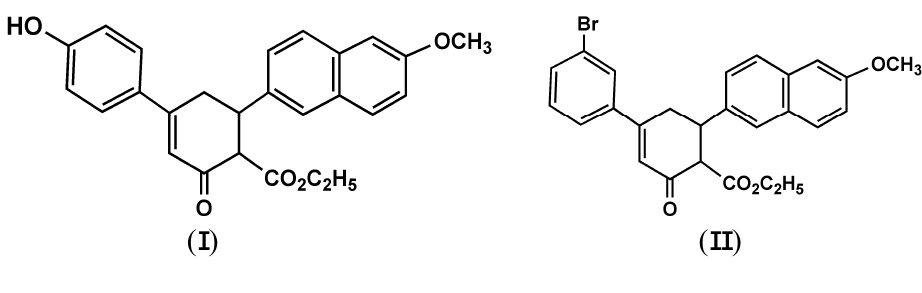
H O ; and ( II ) C 26 24 5